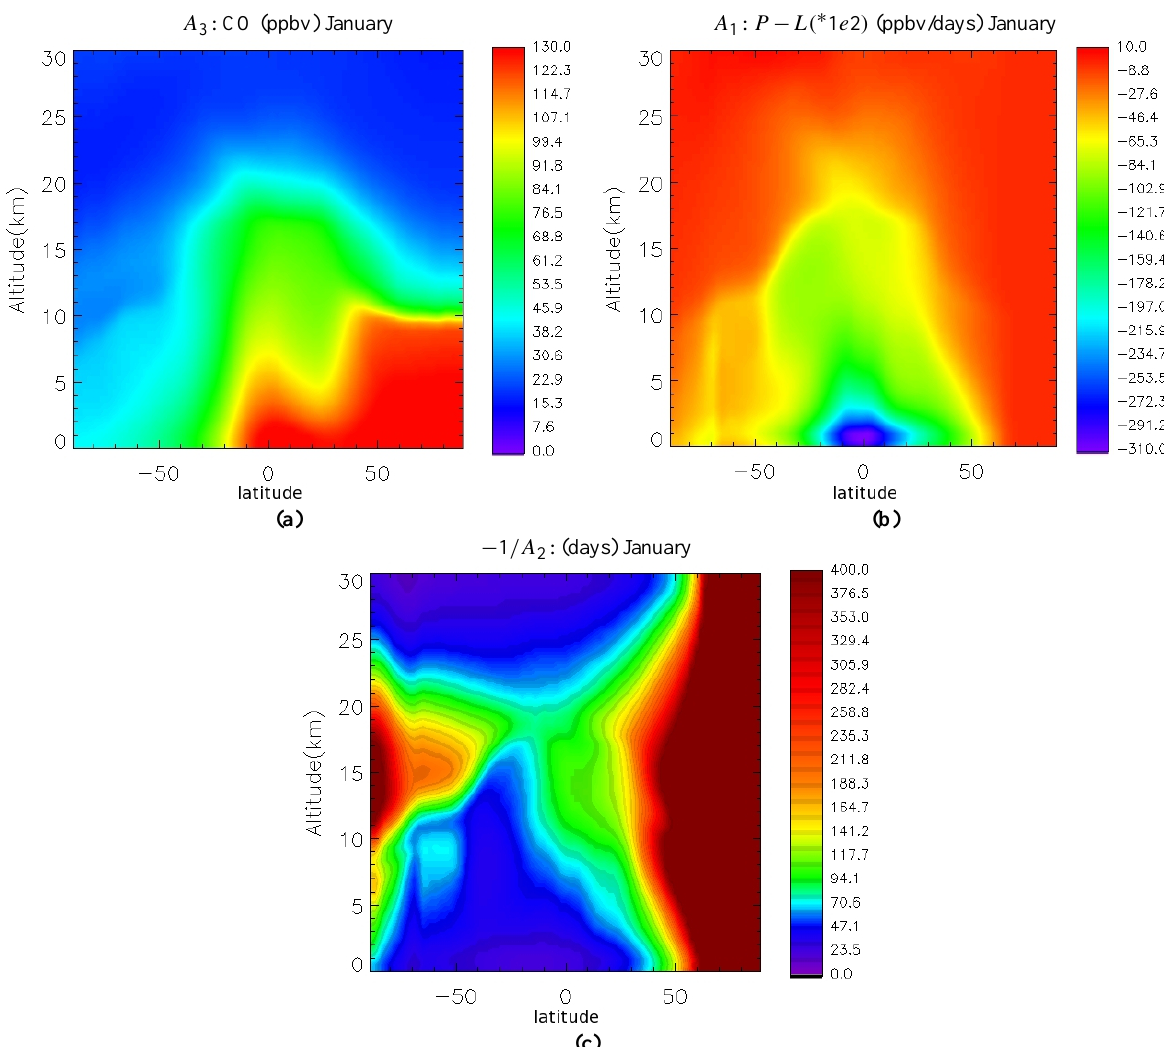
Fig. 1. (a) Background CO distribution in parts per billion by volume (ppbv), (b) net photochemical rate (ppbv/days) and (c) photochemical relaxation time (days) as a function of altitude and latitude for the month of